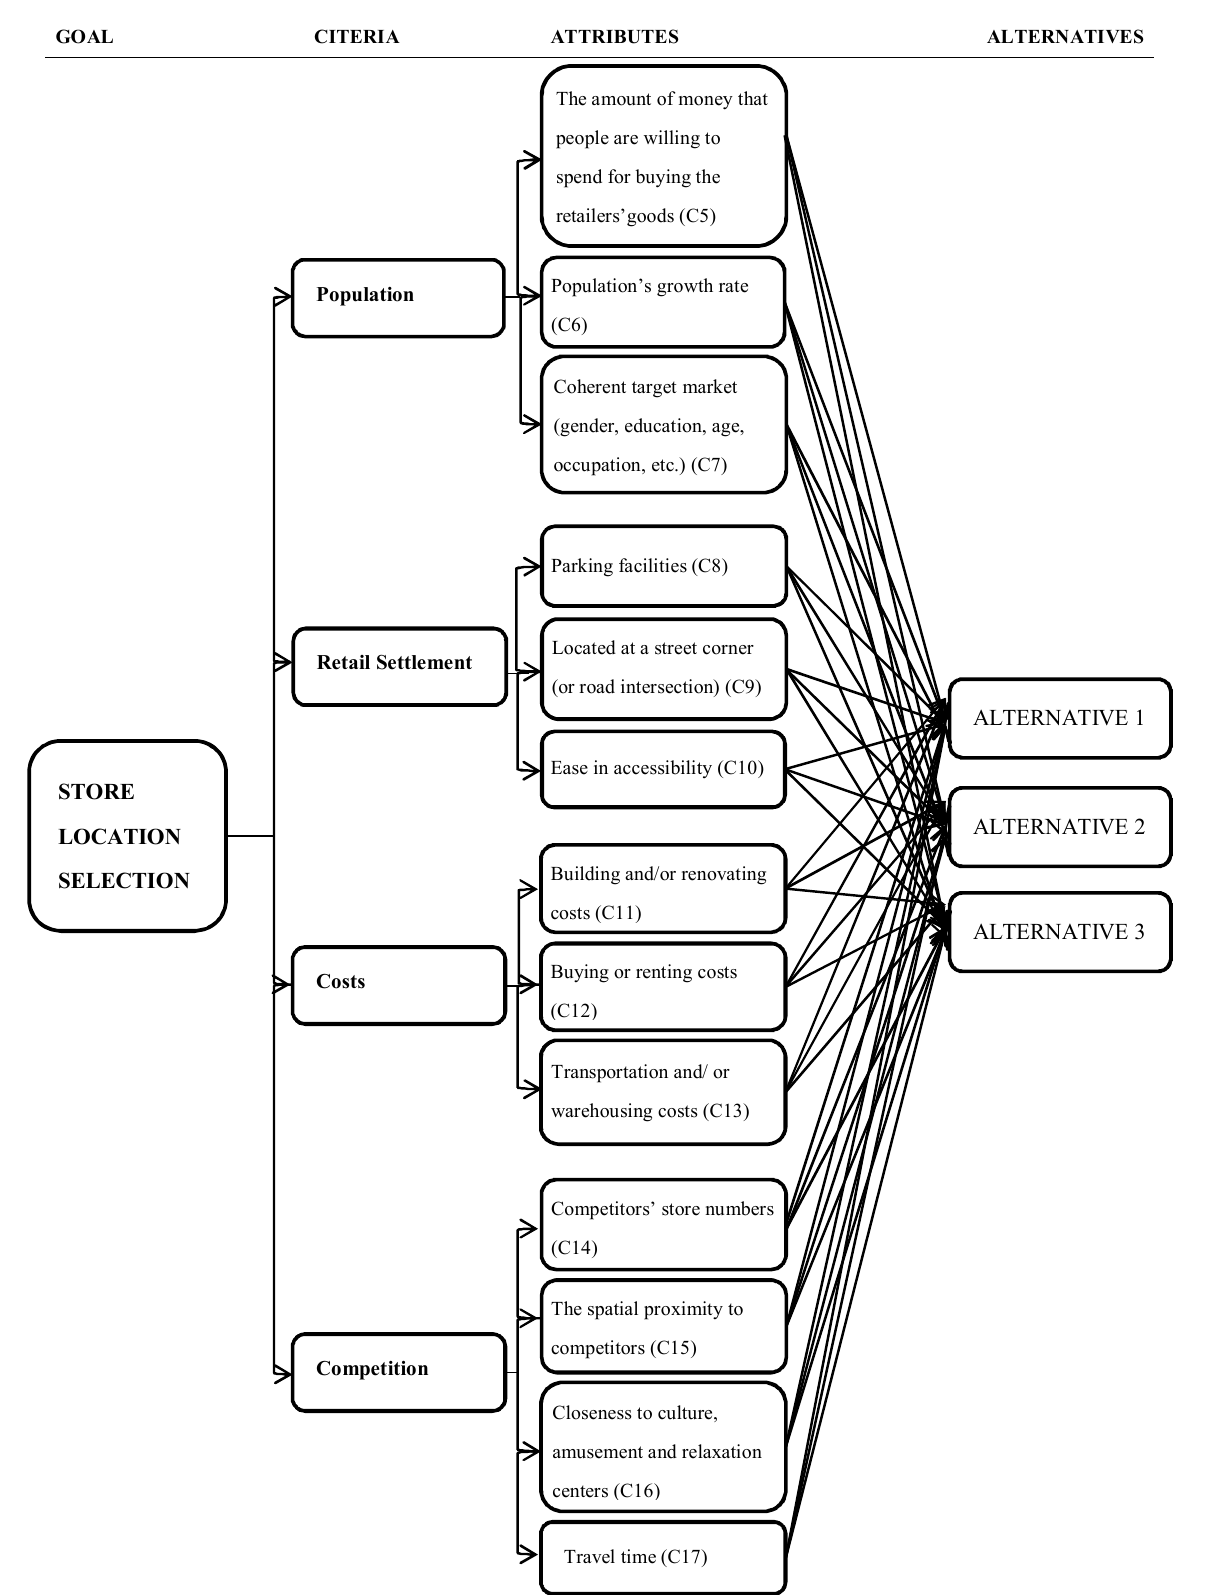
Fig. 2. The Hierarchical Structure of Store Location